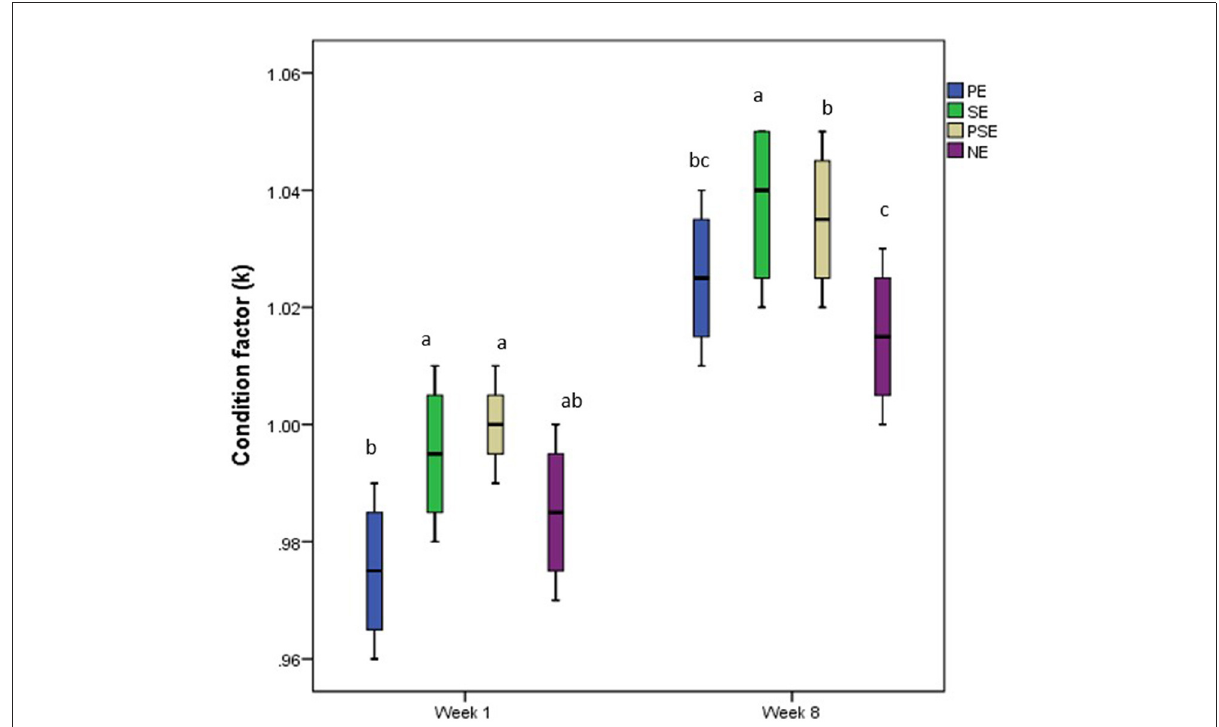
FIGURE2 Change in condition factor (k) of juveniles of Clarias gariepinus exposed to different forms of environmental enrichment (PE, Plant enriched; SE, substratum enriched; PSE, plant and substratum enriched; NE, non-enriched) at week one and eight of the experimental period.